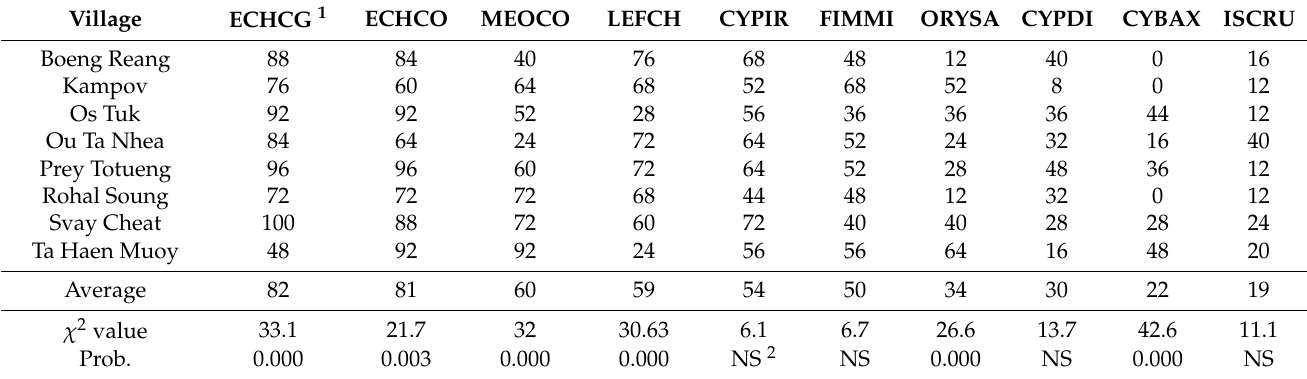
Table 5. Farmer ranking of the 10 most important weed species in their rice fields (% of